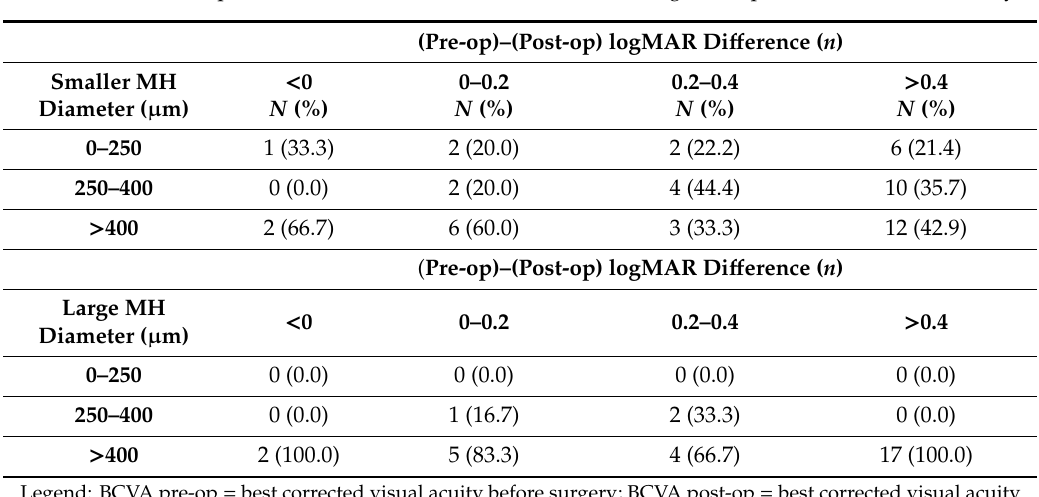
Figure 2. Relationship between pre- and post-op logMAR and closure of the macular hole (median, IQR, range). Statistical analysis was performed using the Wilcoxon Signed Rank Test. Table 5. Relationship between di ff erence MH diameters and change or improvement in visual